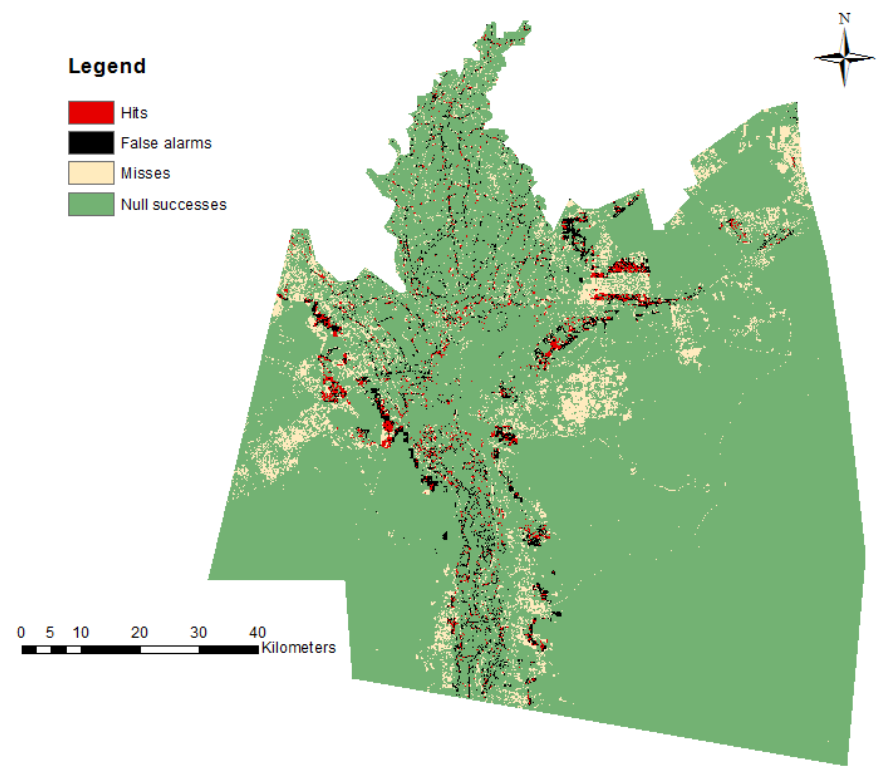
Figure 6. Visual validation—Map of correctness and error based on 2003 (reference), 2014 (reference), and 2014 (simulated) LULC